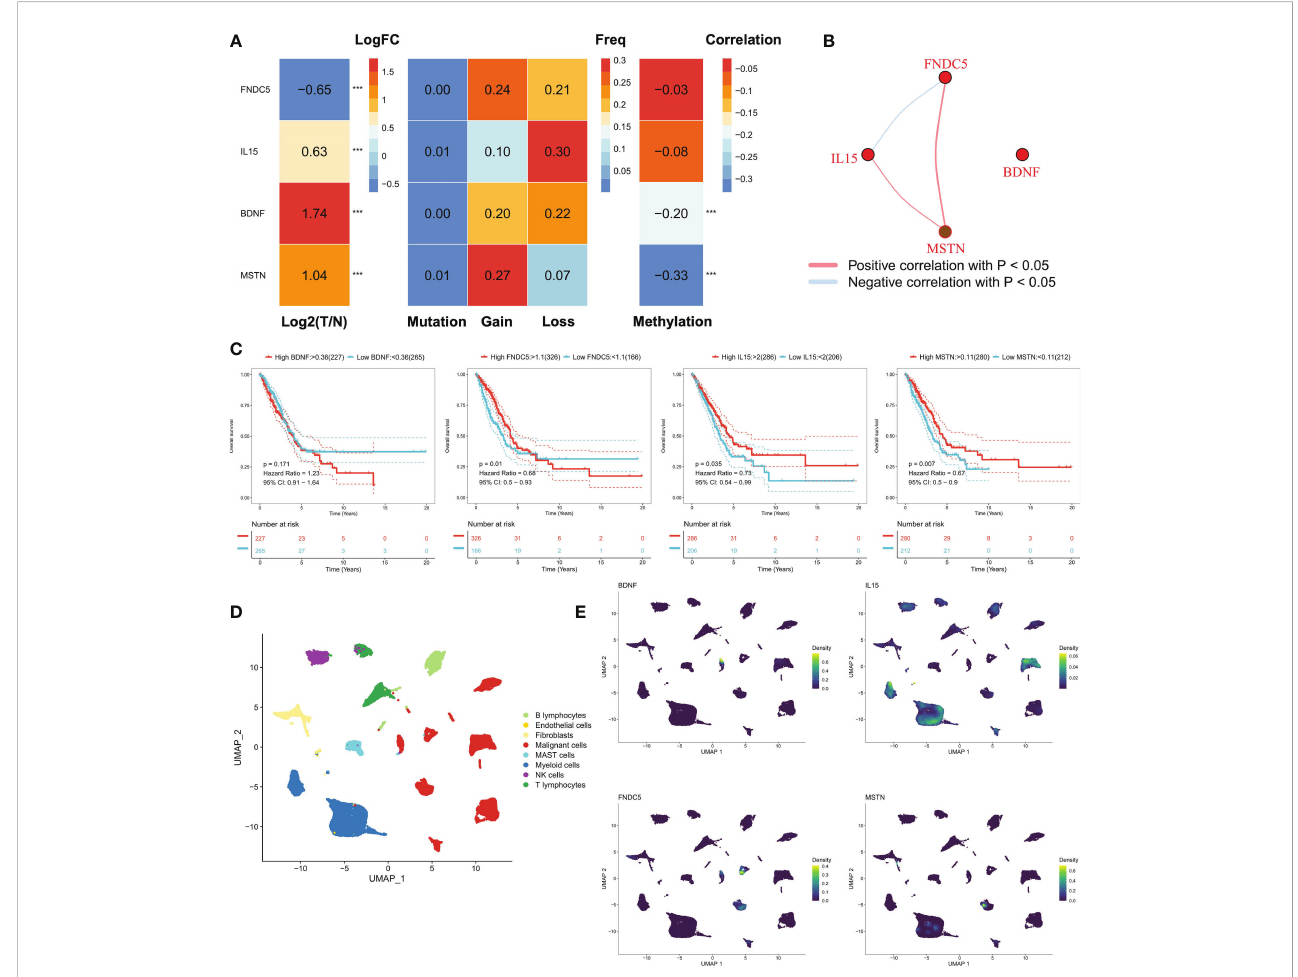
FIGURE 1 Genomic regulation of myosin genes in LUAD. (A) Transcriptomic pro fi les of the mRNAs of four secreted proteins, from left to right: analysis of the differences between tumor and normal samples, FNDC5 was down-regulated, while IL15, BDNF, and MSTN were up-regulated; mutations: all four genes had few mutations and mutations were not the main regulators of these genes; the frequency of chromosomal ampli fi cation and deletion at the corresponding loci could be seen to be substantial. In terms of genomic variation, these four proteins were mainly regulated by copy number variation, for example, the ampli fi cation number of MSTN was high, which may lead to its overexpression; methylation regulation, the methylation levels of BDNF and MSTN were negatively correlated with mRNA expression, and lower methylation levels may lead to the abnormal increase of BDNF and MSTN in tumor samples. (B) Correlation of the four genes, BDNF was not signi fi cantly correlated with the other three genes, while IL15 was negatively correlated with FNDC5 and positively correlated with MSTN; MSTN and FNDC5 were positively correlated. (C) The survival curves of four genes, FNDC5, IL15 and MSTN were all favorable factors for OS in LUAD patients, while BDNF had no signi fi cant effect on survival. (D) Cellular subpopulation of lung cancer single cell data, a total of 8 cellular subpopulations were identi fi ed according to the original annotation. (E) Distribution of four genes in different cell subpopulations, IL15 was mainly found in immune cells, while BDNF, MSTN and FNDC5 all mainly in malignant cells.